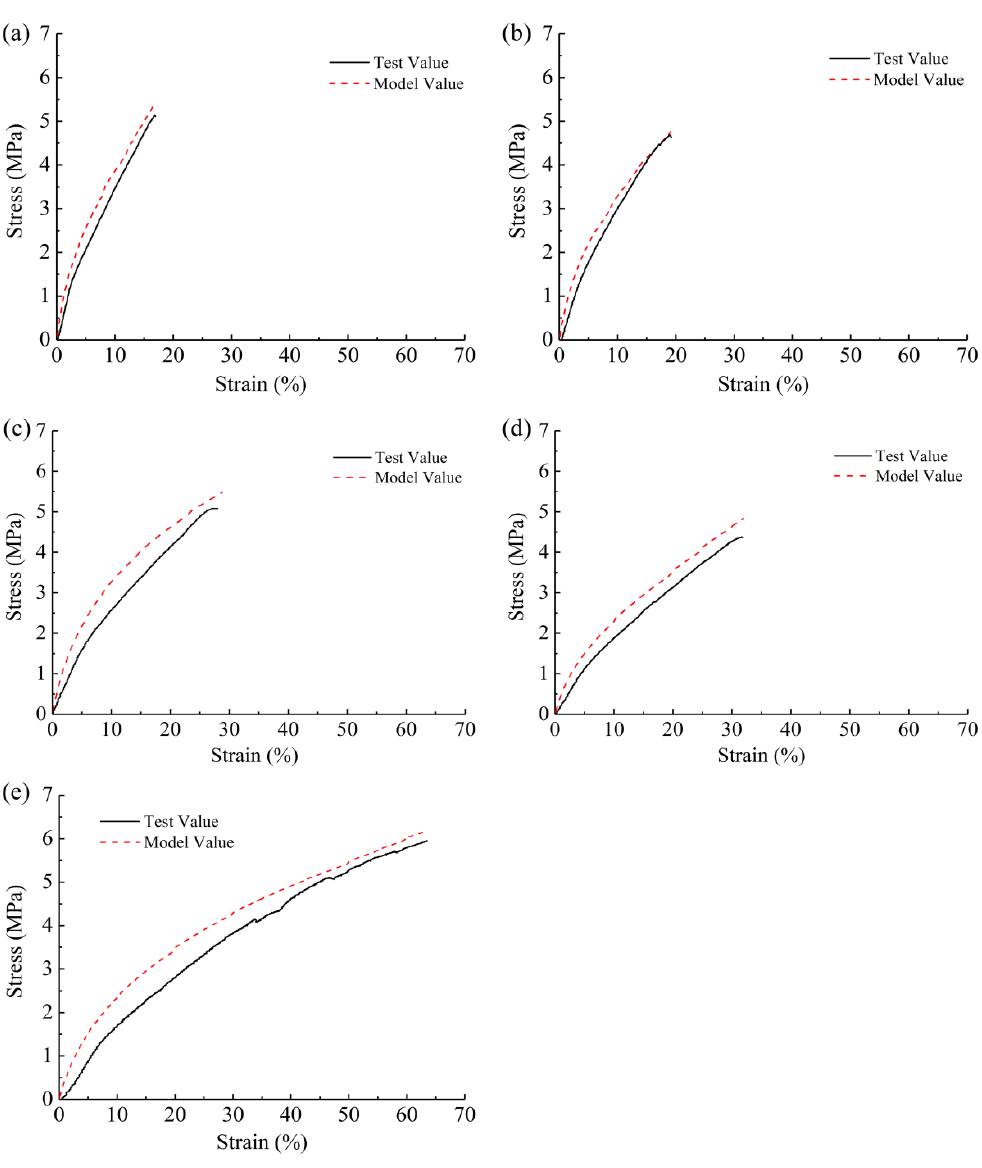
Figure 8. Results of the modeling analysis and experimental tests: ( a ) W SF :W PCL = 100:0, ( b ) W SF :W PCL = 75:25, ( c ) W SF :W PCL = 50:50, ( d ) W SF :W PCL = 25:75, and ( e ) W SF :W PCL = 0:100 membranes.